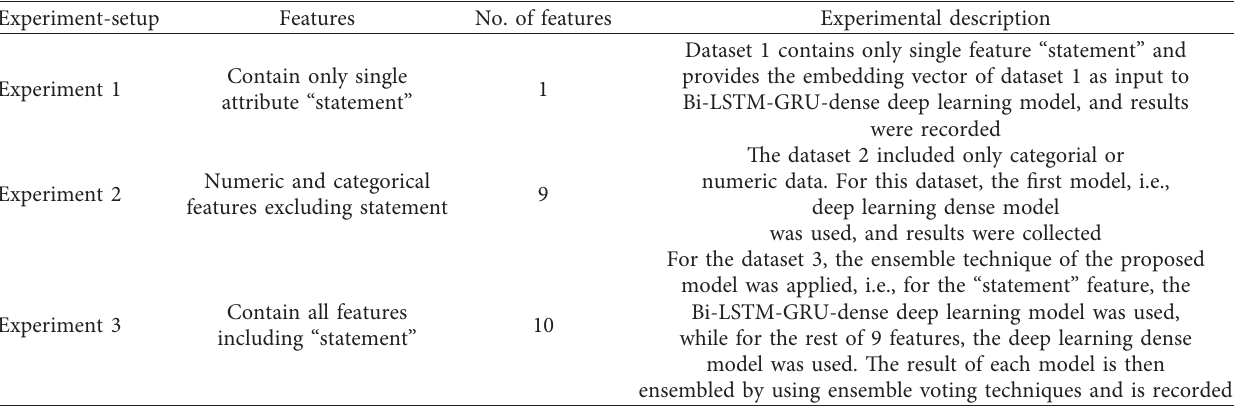
Table 2: Experimental setup, features, and description.